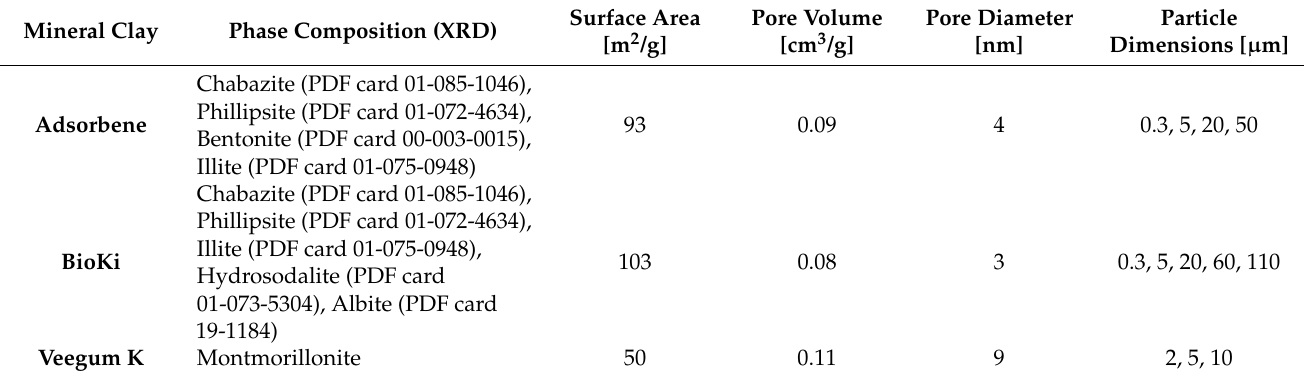
Table 1. Phase composition and morphological characteristics of the considered mineral clays. Mineral